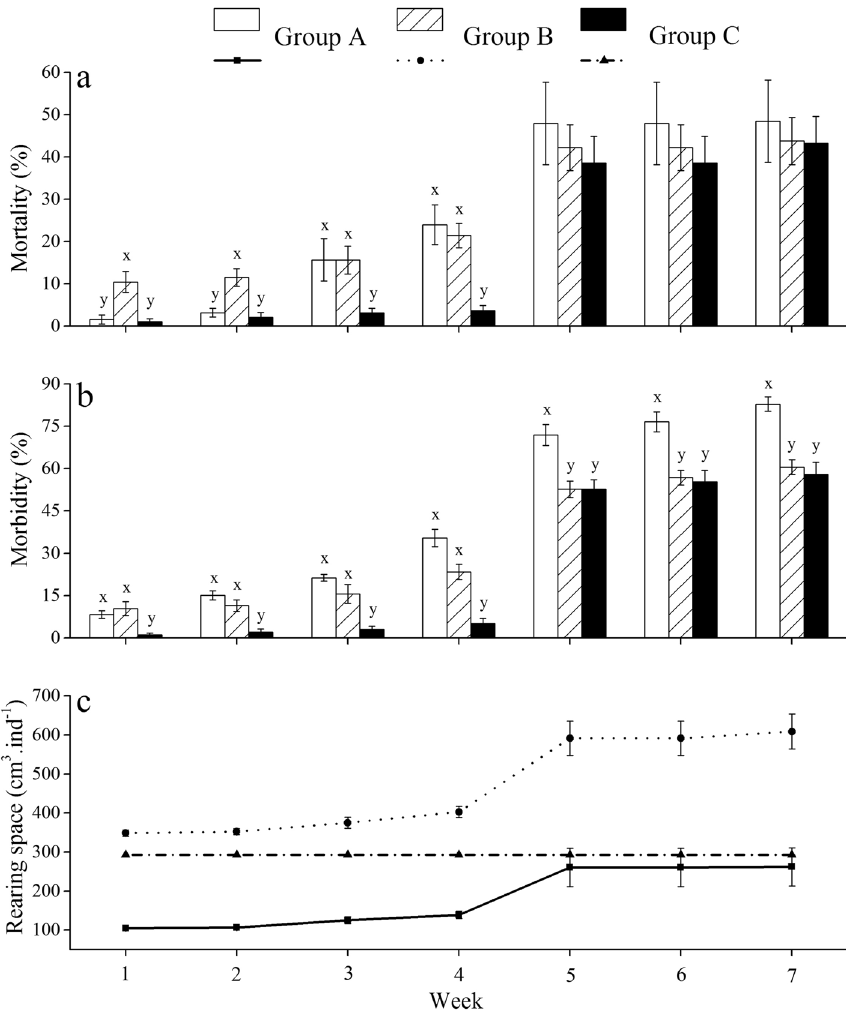
Figure 1. Mortality ( a ) and morbidity ( b ) and rearing space ( c ) of Strongylocentrotus intermedius of the experimental groups during the experiment (mean ± SD, N = 8). Letters above the bars represent significance in each week ( P < 0.05).